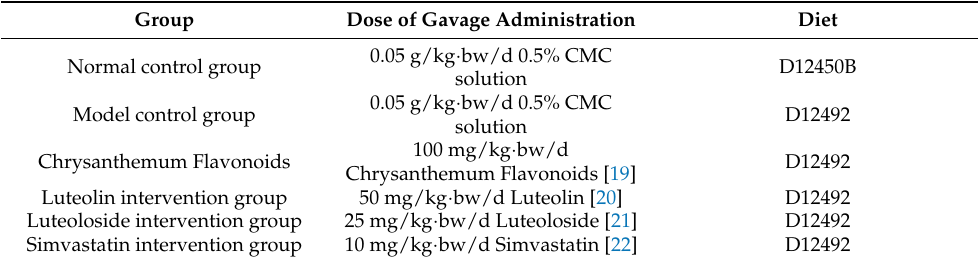
Table 2. Experimental groups and treatment